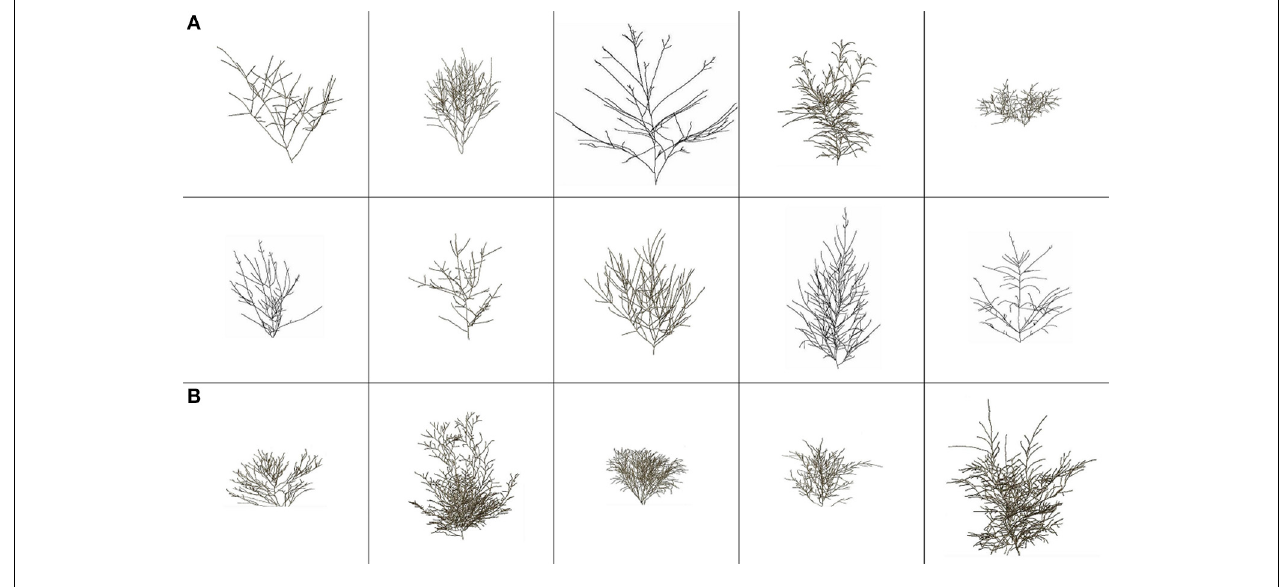
Juniper). Width and height (cm) values (for complete crowns; see Figure 5 ) range from 10.3, 7.9 ( Chamaecyparis pisifera Golden Pin Cushion, Sawara Falsecypress) to 27.5, 22.2 ( Cryptomeria japonica Gyokuryu, Japanese Cedar), respectively. These 3-D renderings and those of Figure 5 were constructed from CT scanning data, and conserve the relative differences in size (width and height) among the 15 coniferous